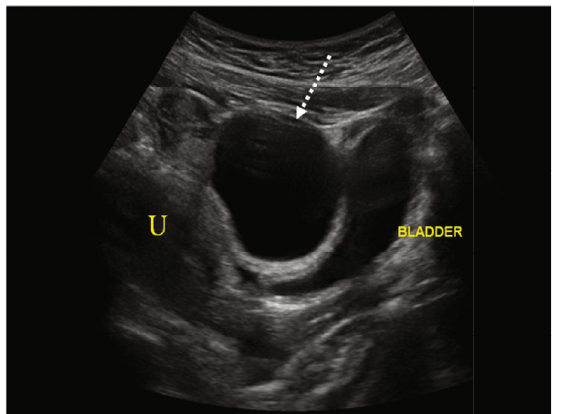
Figure 1: Transabdominal sagittal view of the pelvis demonstrates a large anechoic structure (dashed white arrow) located superior to the bladder and anterior to the uterus (U).